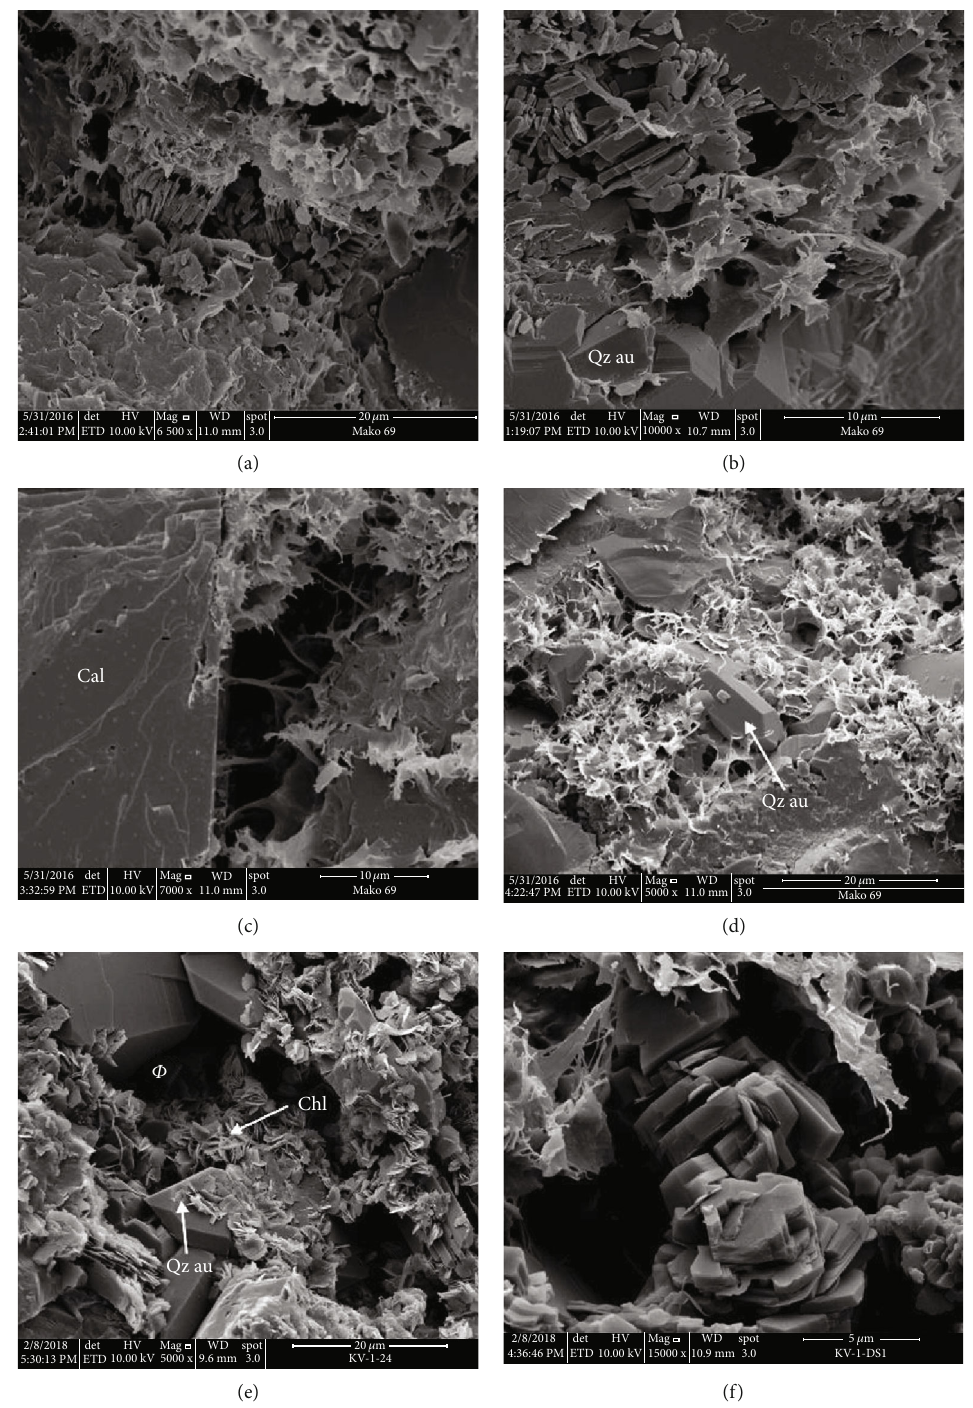
Figure 7: SEM-SE images showing the features of diagenetic clay minerals. (a) Kaolinite occurs together with mixed-layer illite/smectite, well M7, 3421 m, Szolnok Fm. (b) Kaolinite and authigenic microcrystalline quartz, well M7, 3421m, Szolnok Fm. (c) Pore-bridging illite, well M7, 3421m, Szolnok Fm. (d) Mixed-layer illite/smectite forms intergrowths with diagenetic quartz, well M7, 3412m, Szolnok Fm. (e) Pore- fi lling and grain-rimming chlorite locally forming intergrowths with authigenic quartz, well K1, 3023m, Algy ő Fm. (f) Thick layers of kaolinite/dickite with mixed-layer illite/smectite, well K1, 3012m, Algy ő Fm. Abbreviations: Cal: calcite; Qz au: authigenic quartz; Chl: